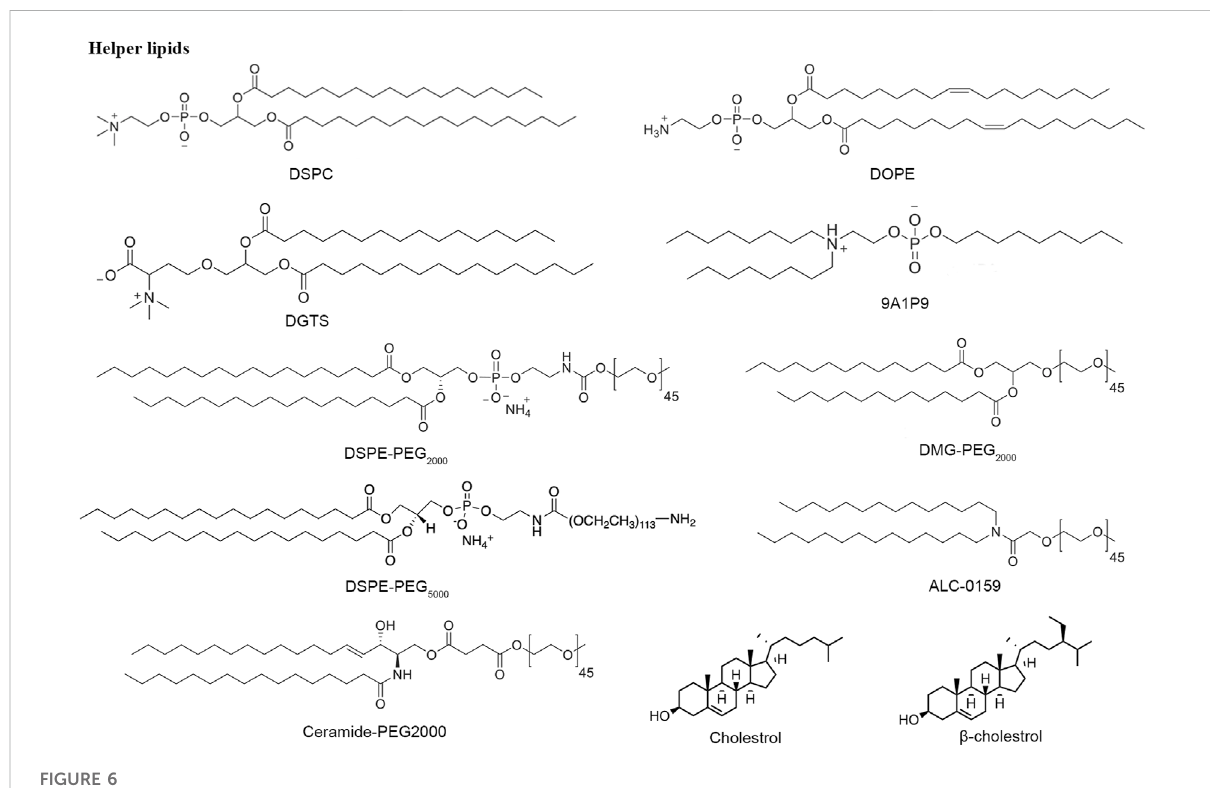
FIGURE 6 Structure of some helper